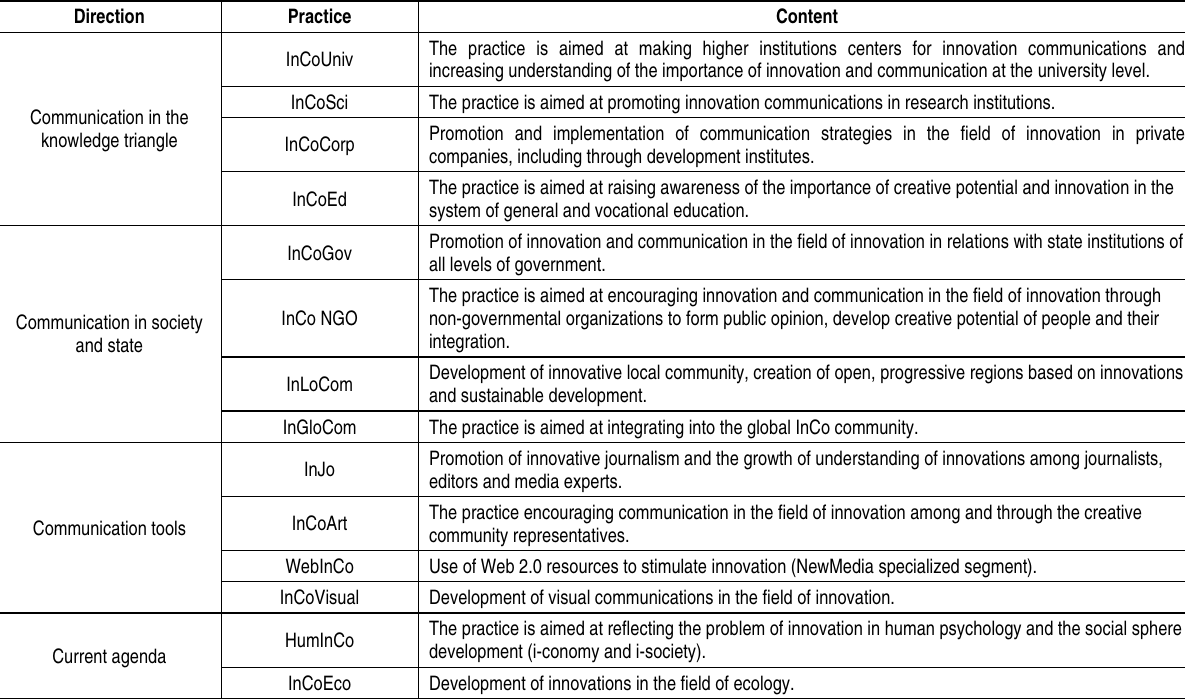
Table 1. Communication in the field of